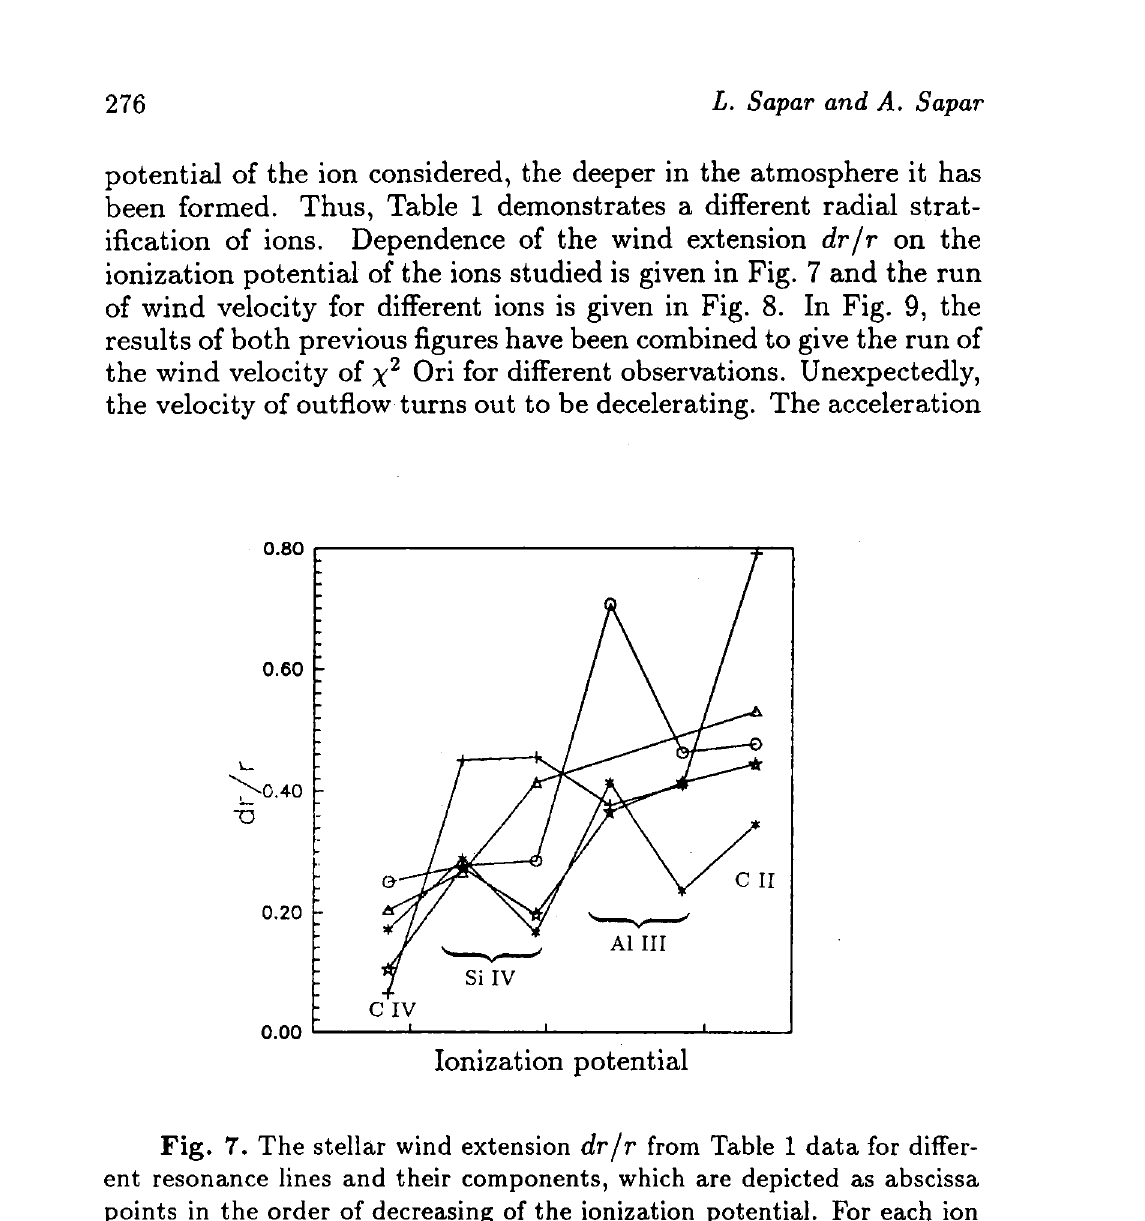
Fig. 7. The stellar wind extension dr/r from Table 1 data for differ- ent resonance lines and their components, which are depicted as abscissa points in the order of decreasing of the ionization potential. For each ion there are four to five symbols for different spectrograms. Large differences in the values oi dr/r found from the A1III resonance components show that the results can contain considerable errors. The extension increases with the recombination potential of the ions studied becoming lower. Notations are the following: * for SWP 2970, + for SWP 3436, A for SWP 4302, o for SWP 6471 and * for SWP